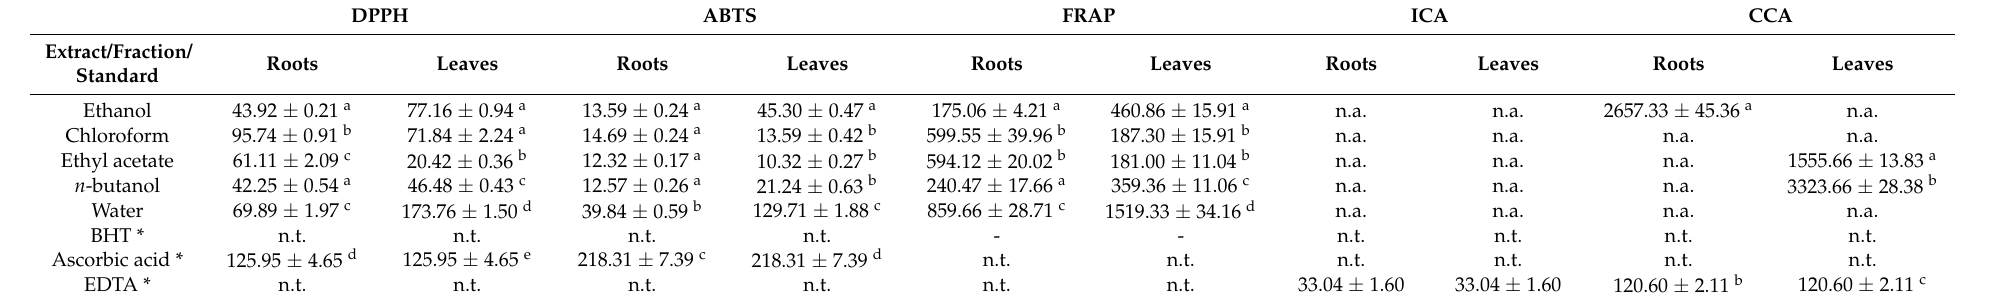
Table 3. Radical-scavenging activity on DPPH and ABTS + radicals, ferric reducing antioxidant power (FRAP), and metal-chelating activities on iron (ICA) and copper (CCA) of ethanol extracts from L. intricatum and obtained fractions. Results are expressed as EC 50 values ( µ g/mL). DPPH ABTS FRAP ICA